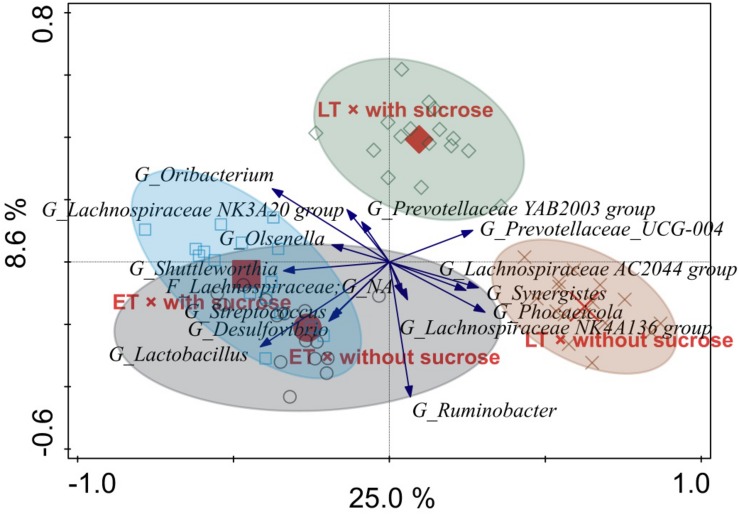
Redundancy analysis triplot illustrating the relationship between the top 15 genus-level phylogenetic groupings of the operational taxonomic units (OTU) for solid-associated microorganisms explaining the variance of the interaction of time point × sucrose addition with the covariates vessel and experimental run. Arrow length indicates the variance that can be explained by the interactions. Arrow labels indicate the taxonomic identification of genus-level phylogenetic groupings, with the level [i.e., phylum (P), class (C), order (O), family (F), or genus (G)]. Abbreviation NA indicates the levels that could not be annotated, for instance “F_Lachnospiraceae; G_NA” was reliably assigned to the family Lachnospiraceae, but the genus could not be annotated. Sample codes for the means indicate the different time points, i.e., early (ET) and late (LT), as well as the sucrose addition, i.e., with sucrose or without sucrose.